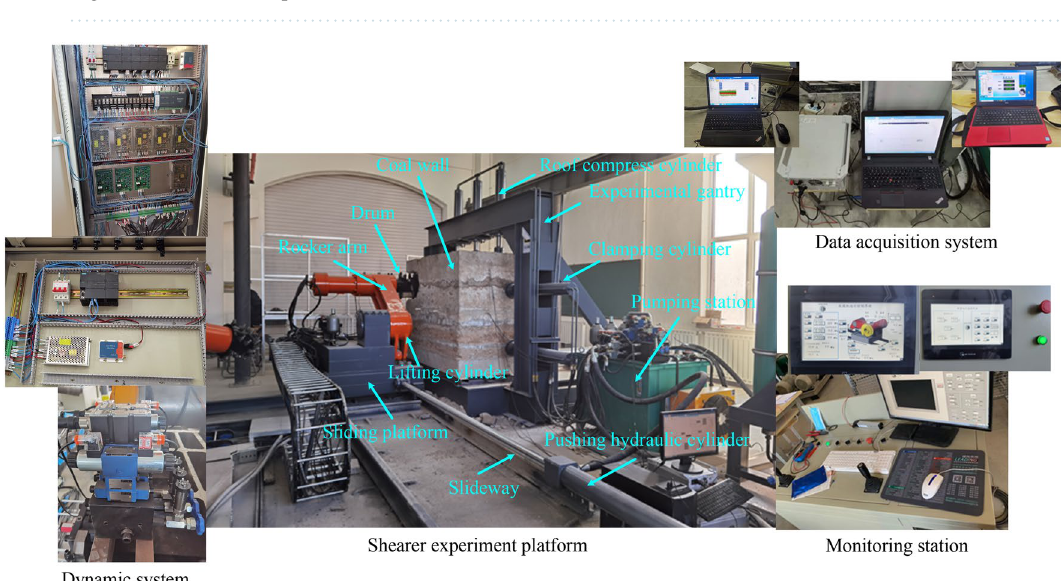
Figure 16. Experimental